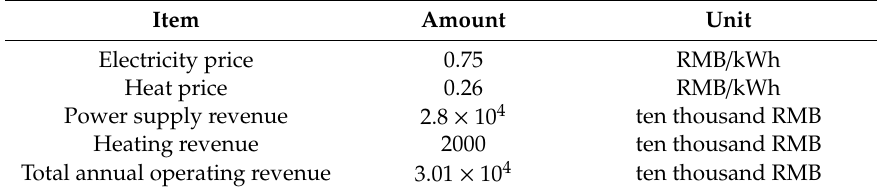
Table 4. Technical and economic indicators and annual income